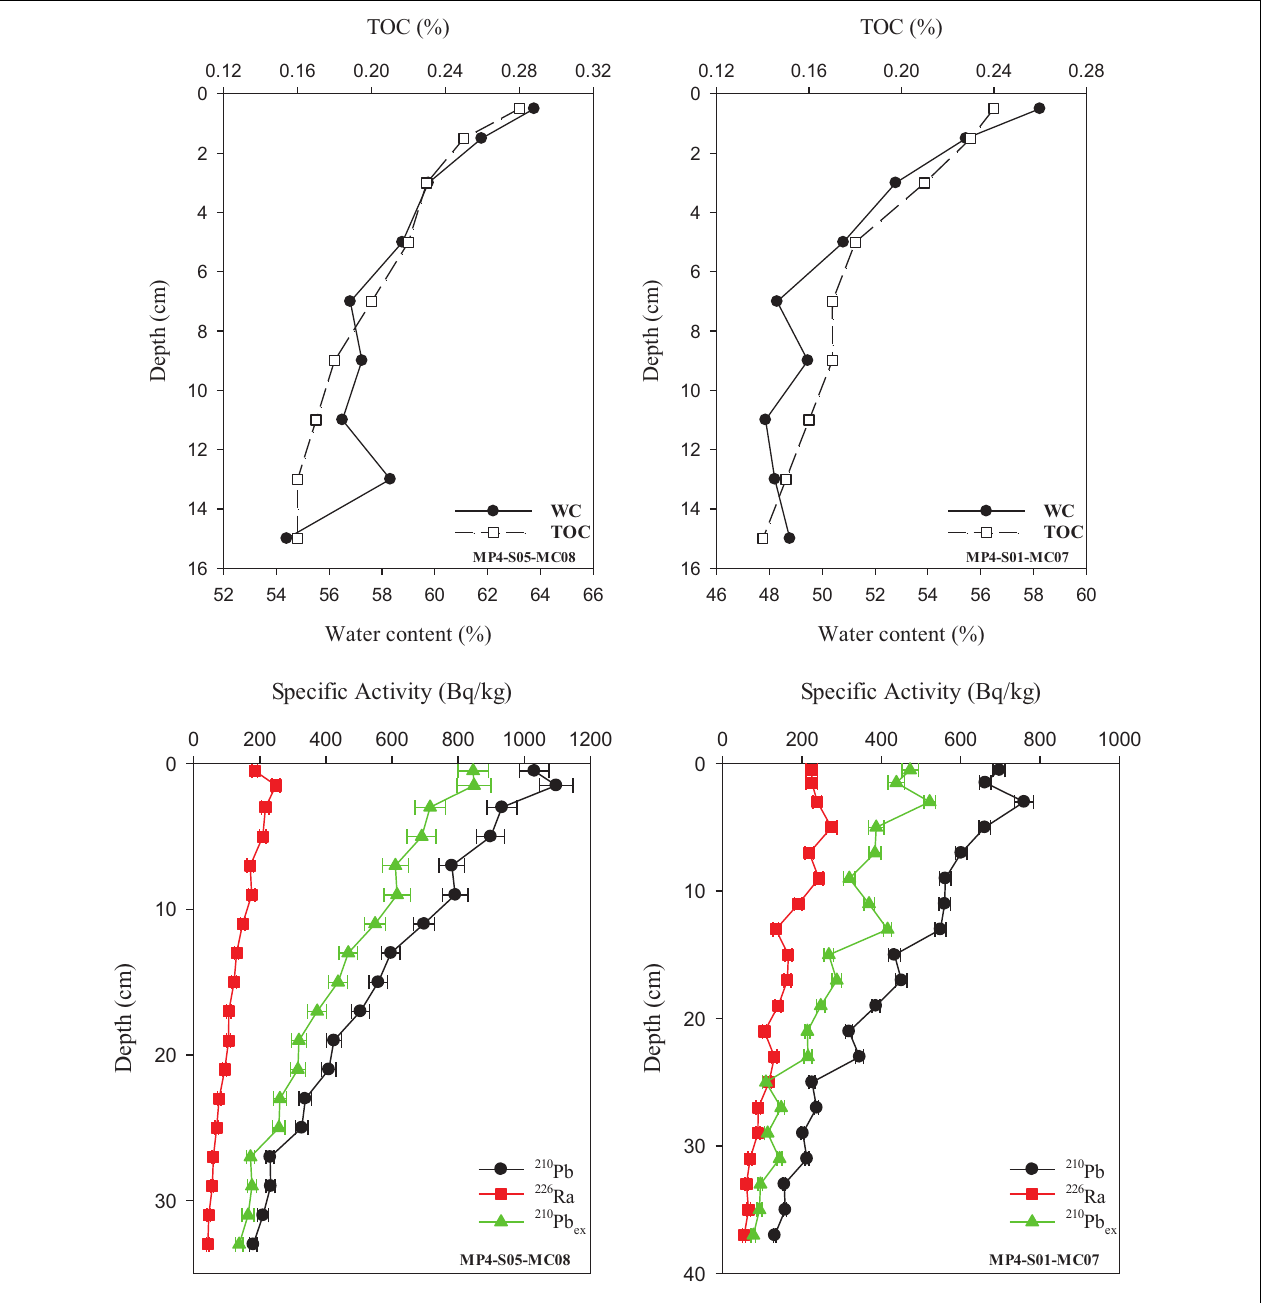
FIGURE 2 | Profiles of total organic carbon, water content, and activity of 210 Pb, 226 Ra, and 210 Pb ex in sediment cores.